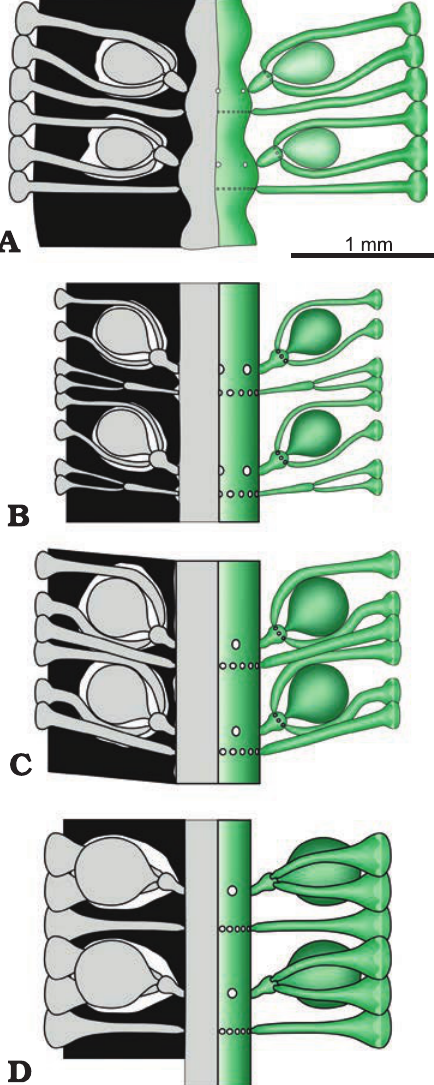
Fig. 12. Late Triassic species of dasycladalean alga Distefanopolia gen. nov. A . Distefanopolia micropora (Di Stefano, 1981 ex Di Stefano and Senowbari-Daryan, 1985) nov. comb. B . Distefanopolia zanklii (Ott, 1968) nov. comb. C . Distefanopolia carpatica (Bistricky, 1967) nov. comb. D . Distefanopolia crosii (Ott, 1968) nov. comb. Calcified skeleton (black) and soft parts (grey and